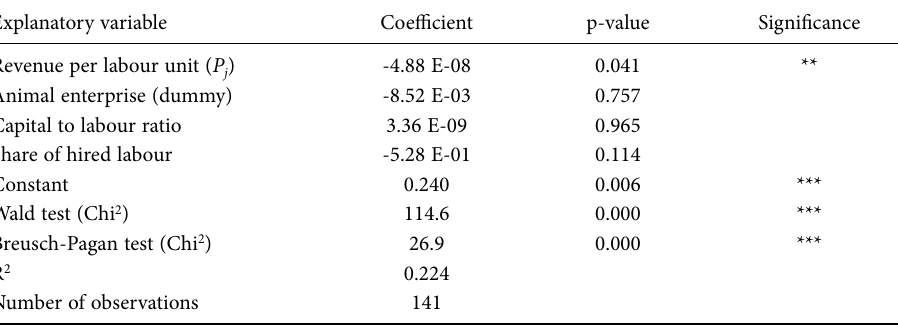
Table 3. Explaining the share of part-time farms in the country’s agricultural production, using the rev- enue as the proxy for financial returns.